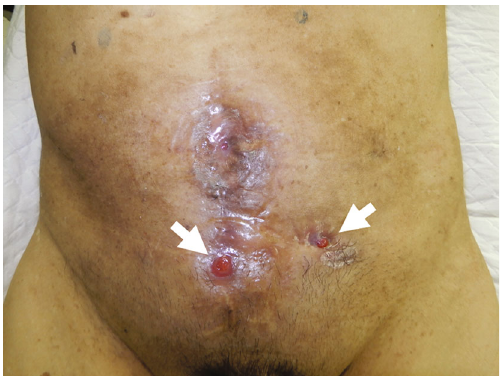
Figure 1: Abdominal fi nding. Cutaneous fi stulas are seen in the mid and left lower abdomen (arrows).